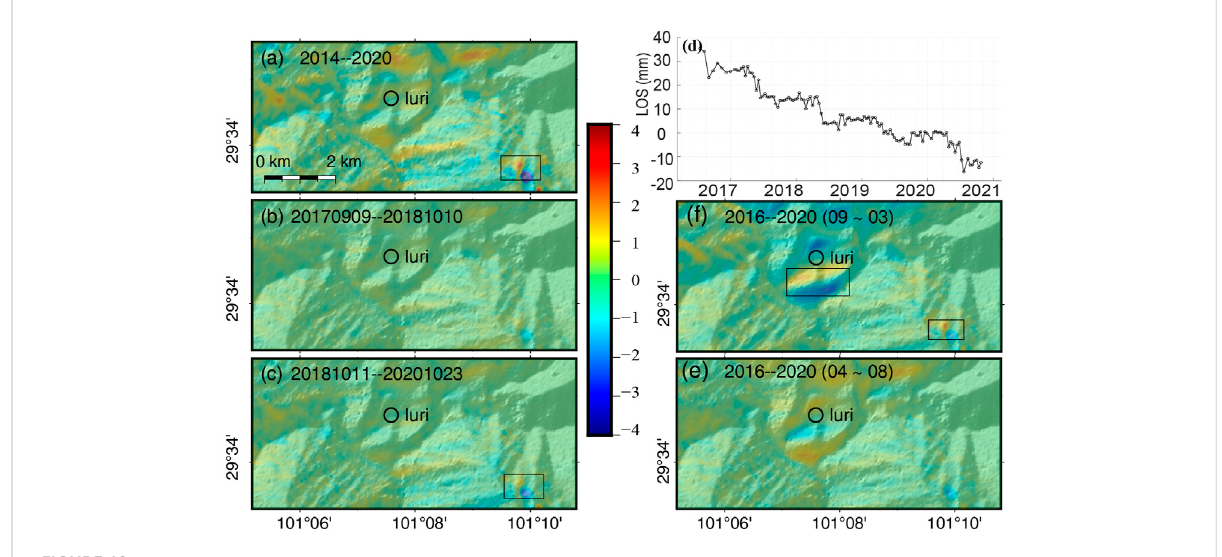
FIGURE 12 Stacked phase-gradient maps in the azimuth direction for the Luri landslide from (A) 2014 to 2020, (B) from September 2017 to October 2018, (C) from November 2018 to October 2020, and (D) the deformation series of the Luri landslide. Stacked phase-gradient maps in azimuth from (E) only images in September to the following March and (F) in April to August from 2016 to 2020. The black box indicates slow-moving landslides detected using the Attention-YOLOv3